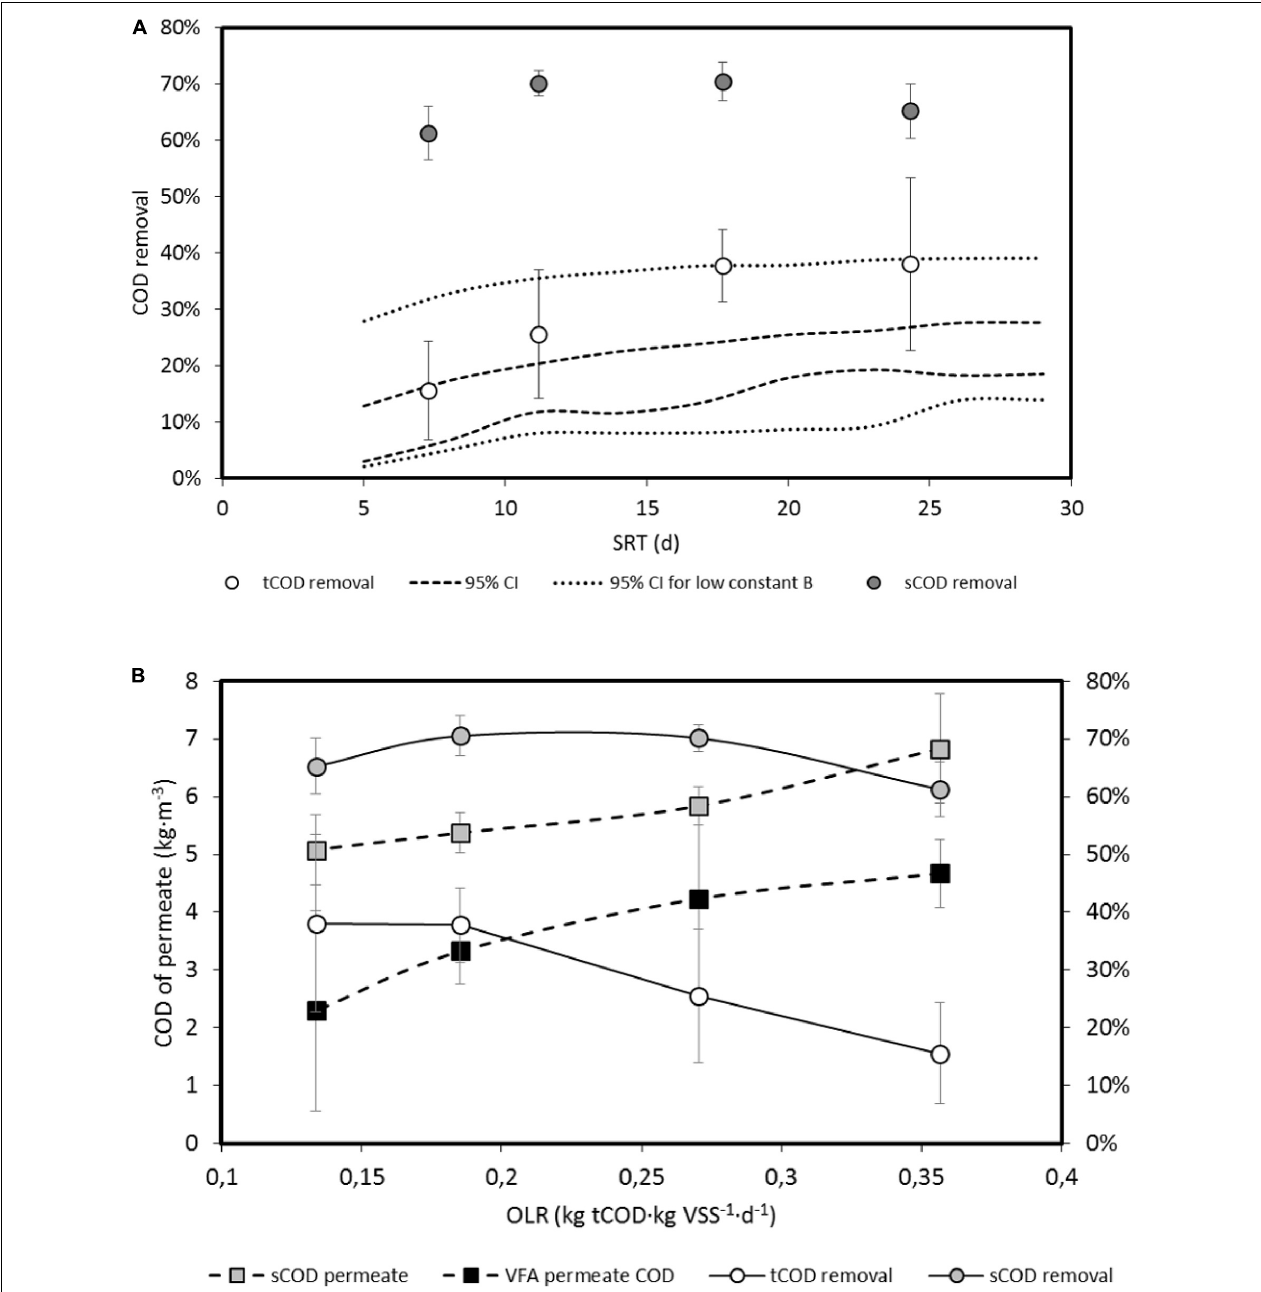
FIGURE 6 | (A) Total and soluble COD removals (tCOD and sCOD) for the SRT values tested. Dotted lines express the estimated 95% confidence intervals (CIs) obtained by numerical simulation using model 2 using parameters of Table 5 (95% CI) or using upper interval of parameter B decreased by 1/5. Error bars indicate standard deviation. (B) Overall sCOD and tCOD removals and sCOD and VFA concentrations in permeate vs. different OLR. Error bars indicate standard